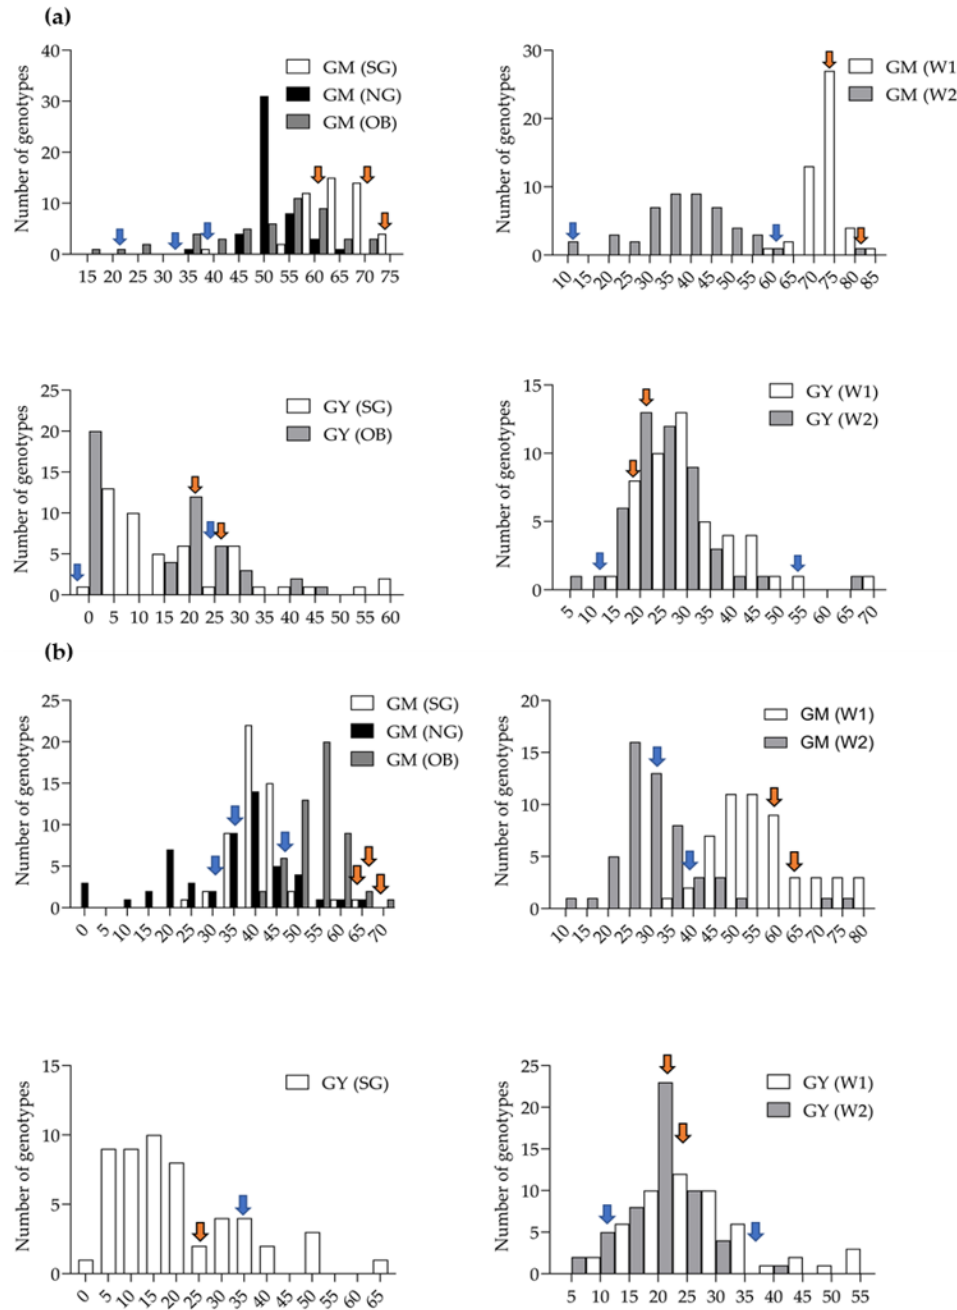
Figure 5. Frequency distribution of percentage greenness at maturity (GM) and grain yield (GY) of the ( a ) 46 and ( b ) 52 stay-green introgression lines and their parents ‘Tabat’, ‘Wad Ahmed’ (in blue arrows), and B35 (in orange arrows) at South Gedaref (SG), North Gedaref (NG), Al Obeid (OB), and Khartoum North irrigated (W1) and drought (W2). Arrows in different columns indicate the values in each trait.